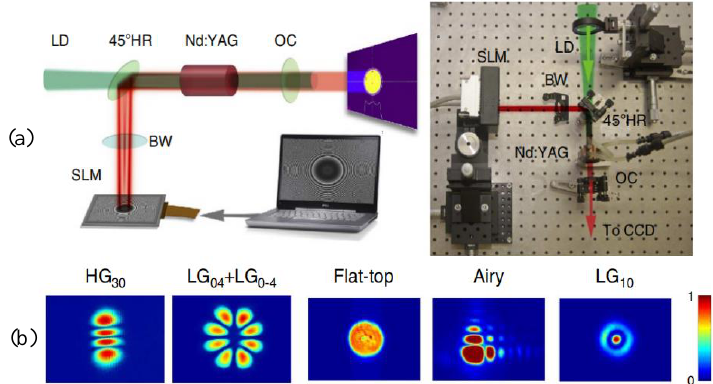
Figure 2. ( a ) Experimental configuration of the proposed laser and ( b ) generated various laser modes by amplitude and phase modulation. (Adapted from an open-access source Ref. [63]).